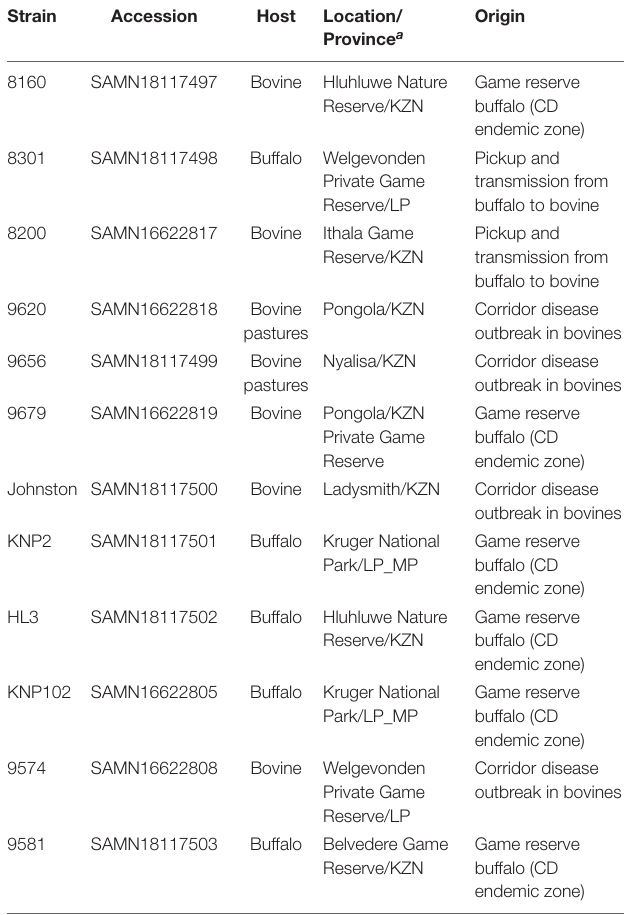
TABLE 1 | Source of samples used in the genomic characterization of Theileria parva